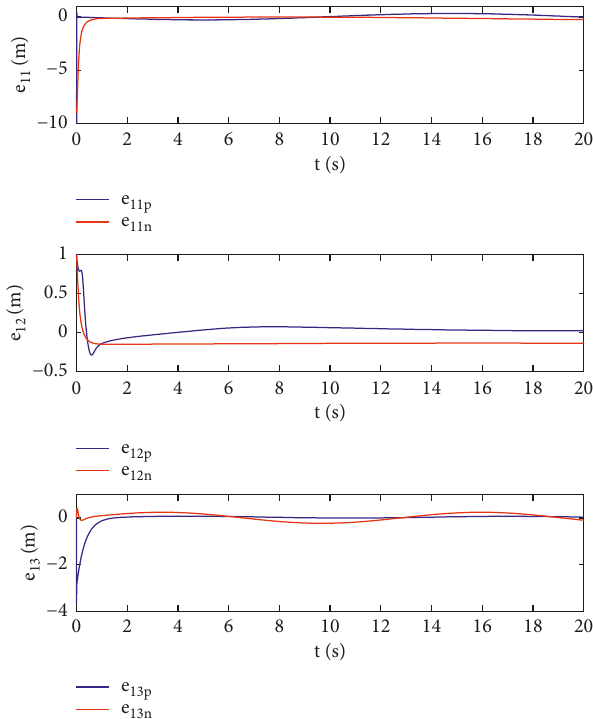
Figure 4: Contrastive results of tracking errors under proposed controller and adaptive FTC method [11].